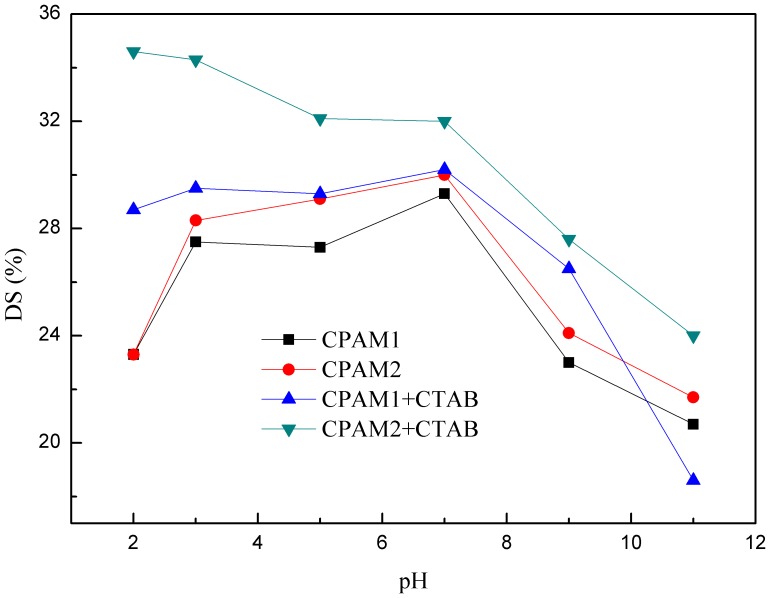
Effect of pH on DS content.